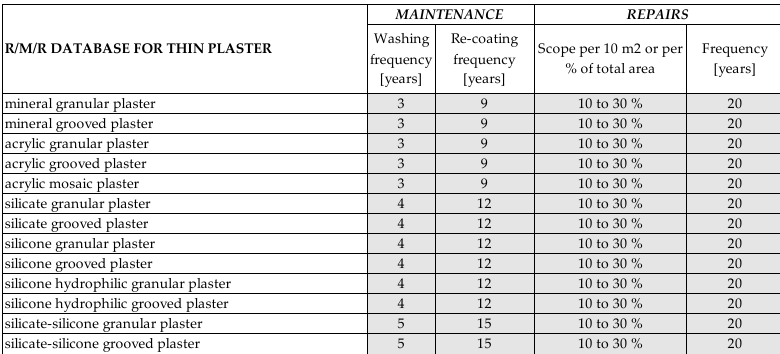
Figure 3. R / M / R database for the LCC calculation of the individual variants (ETICS). Buildings 2019 , 9 , x FOR PEER REVIEW Figure 3. R/M/R database for the LCC calculation of the individual variants (ETICS).